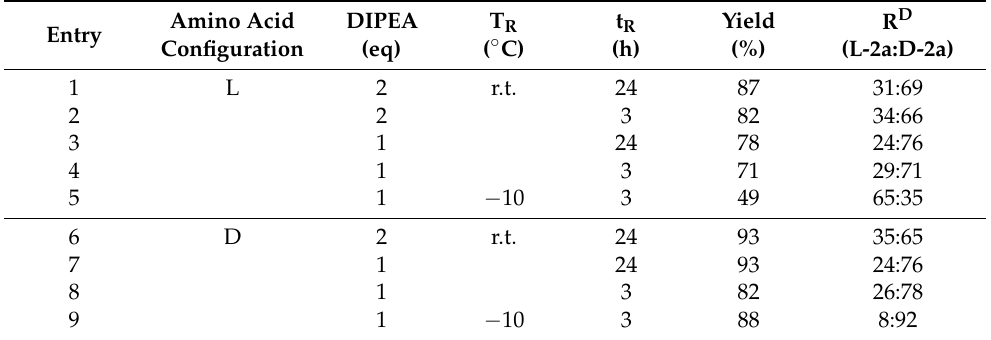
Table 1. Experimental parameters for the coupling of 1 with N -Ac- L / D -phe mediated by TBTU/DIPEA. T R = reaction temperature, t R = reaction time, R D = diastereoisomeric ratio ( L-2a : D-2a ). Yield is referred to the sum of the diastereoisomer 1 .